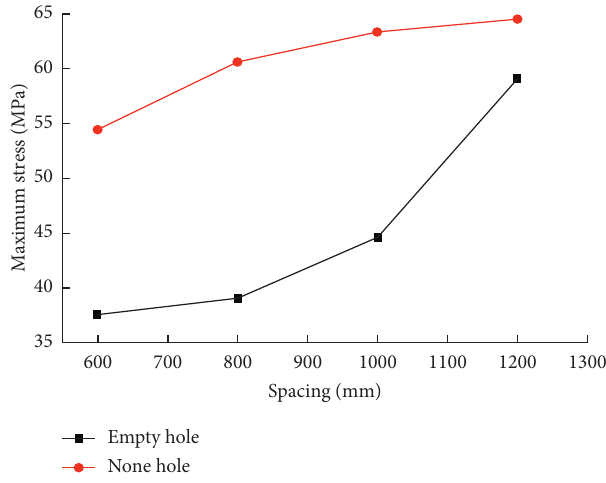
Figure 5: Maximum stress of different